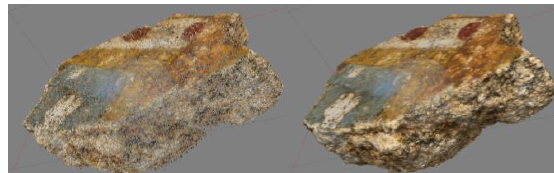
Figure 5: Sparse (left) and dense (right) point cloud of S38 in Agisoft PhotoScan software.